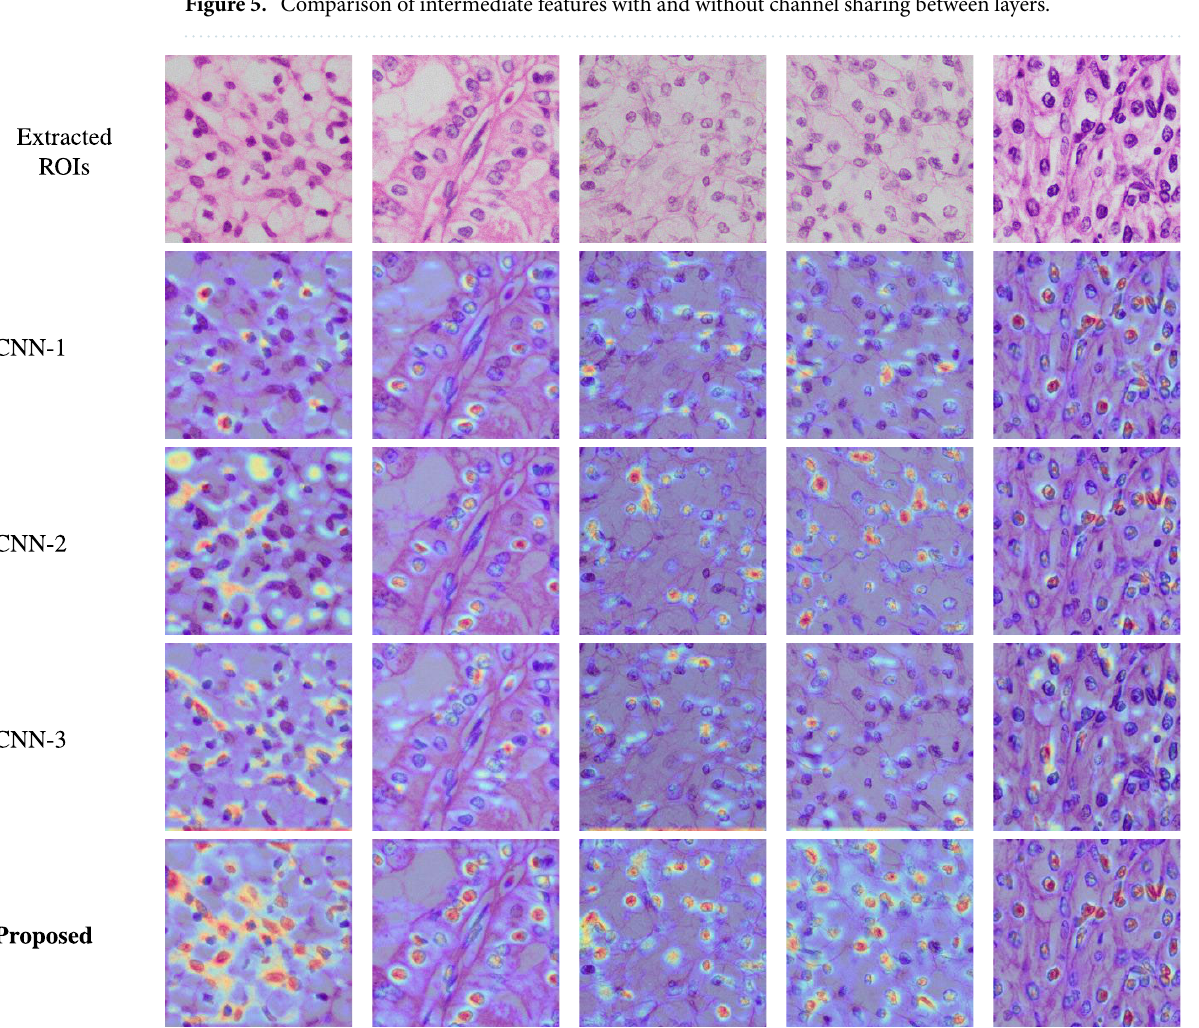
Figure 6. Visual comparison of different CNN variations using activation maps (red: very high probability score regions, orange: medium probability score regions, light blue: low probability score